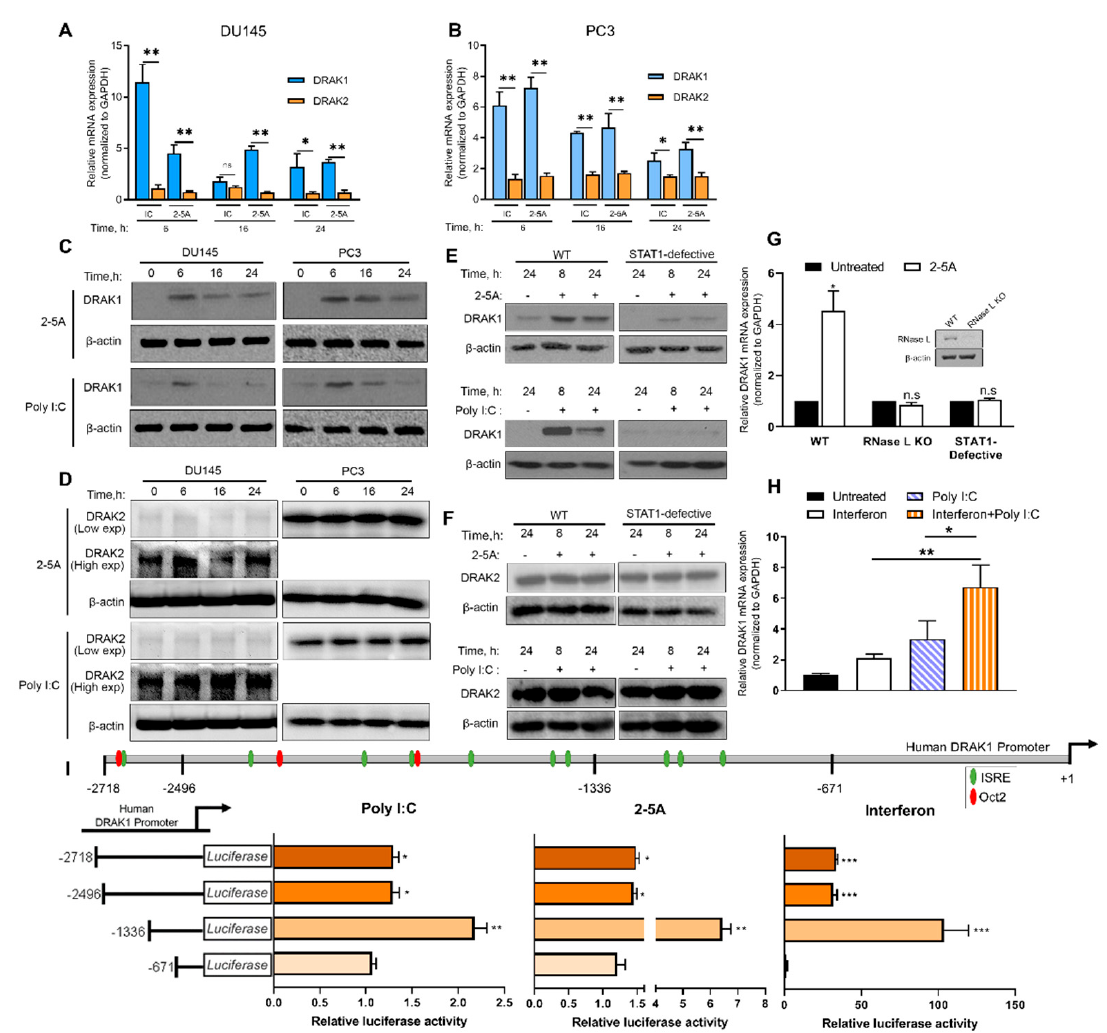
transcriptional induction by RNase L.